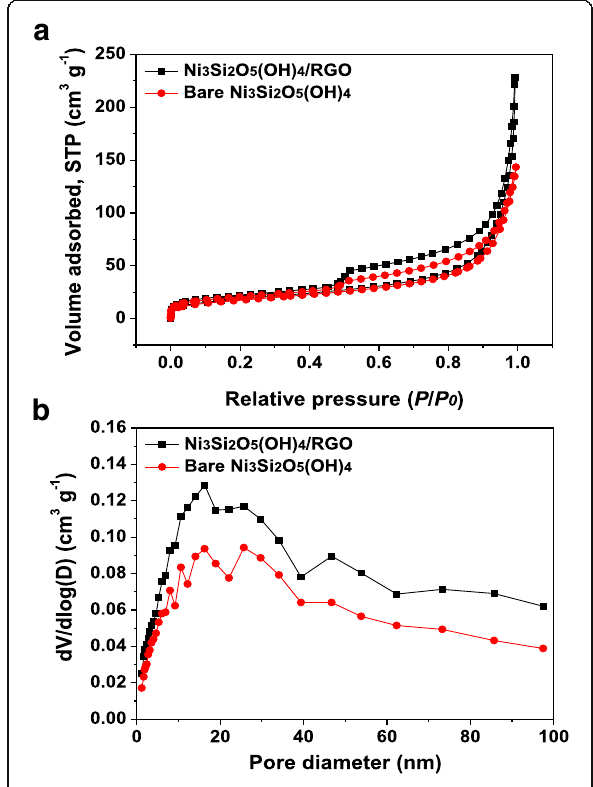
Fig. 6 a Nitrogen adsorption – desorption isotherms and b pore size distribution profiles of Ni 3 Si 2 O 5 (OH) 4 /RGO hollow microspheres ( black curves ) and bare Ni 3 Si 2 O 5 (OH) 4 hollow microspheres ( red curves